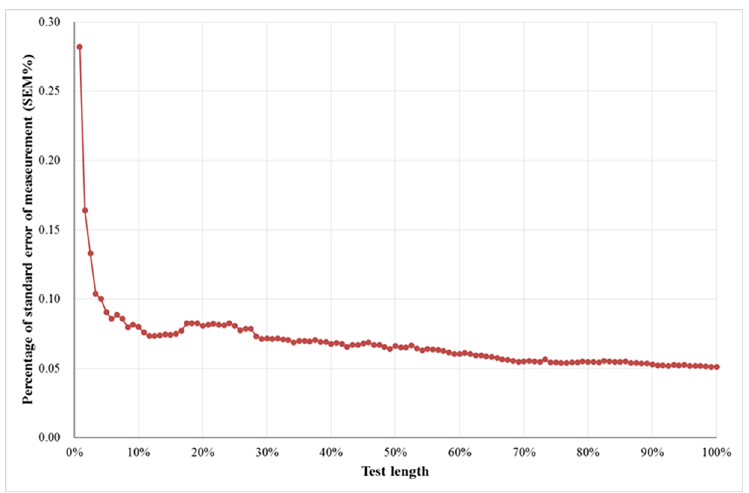
Fig 1. The cumulative reliability (SEM% calculated on the basis of ICC) over trials. The SEM% of each dot is the cumulative reliability (calculated from the first trial to that trial).